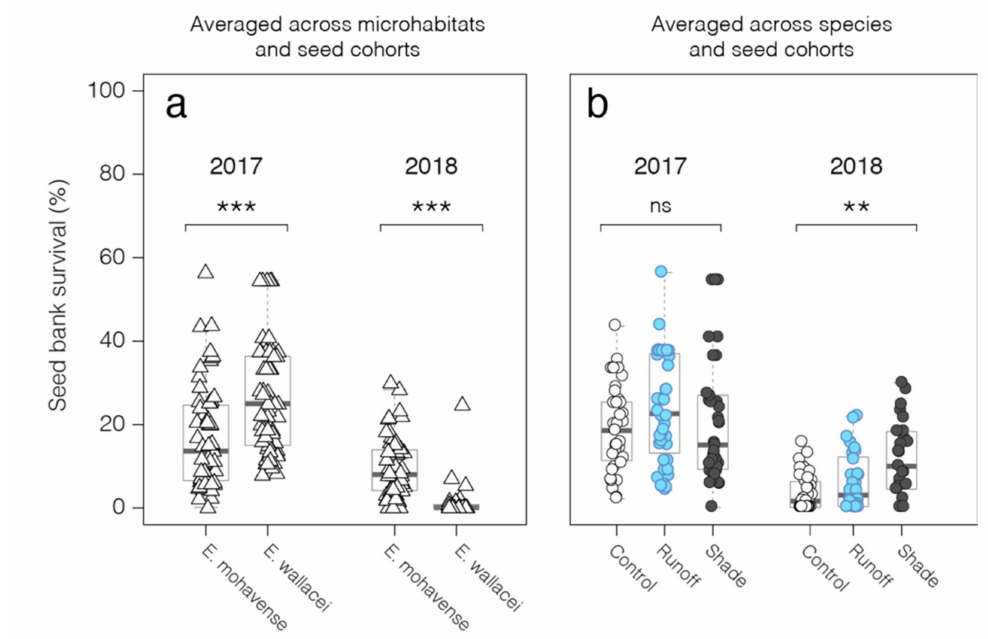
Figure 3. Seed bank survival (%) of E. mohavense and E. wallacei . ( a ) Seed bank survival (%) in 2017 and 2018, averaged across microhabitats and cohorts. ( b ) Seed bank survival by microhabitat in 2017 and 2018 (averaged across species and seed cohorts). ** Indicates a significant di ff erence at the p < 0.01 level. *** Indicates a significant di ff erence at the p < 0.001